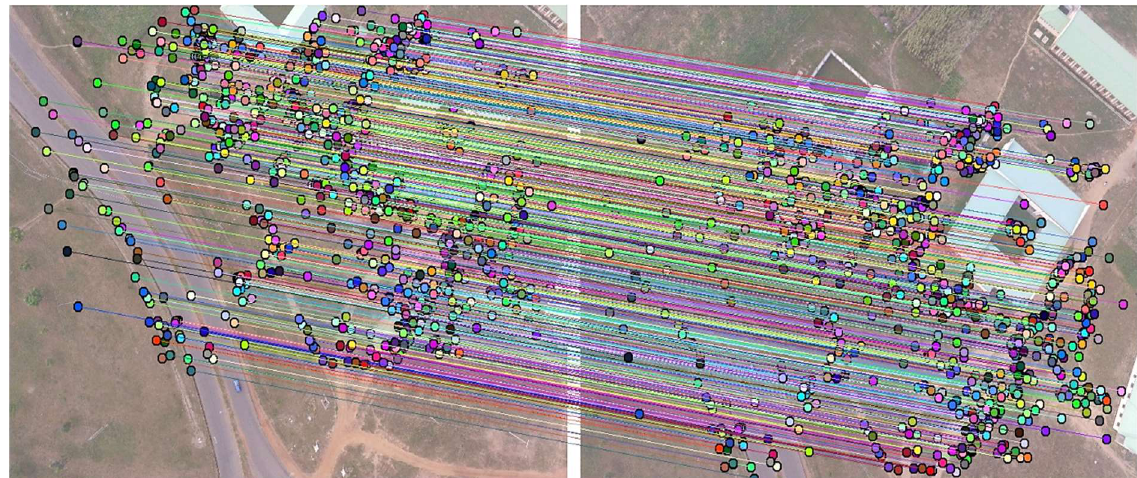
Figure 5c: Matched inliers using Scale Invariant Feature Transform (SIFT) Algorithm